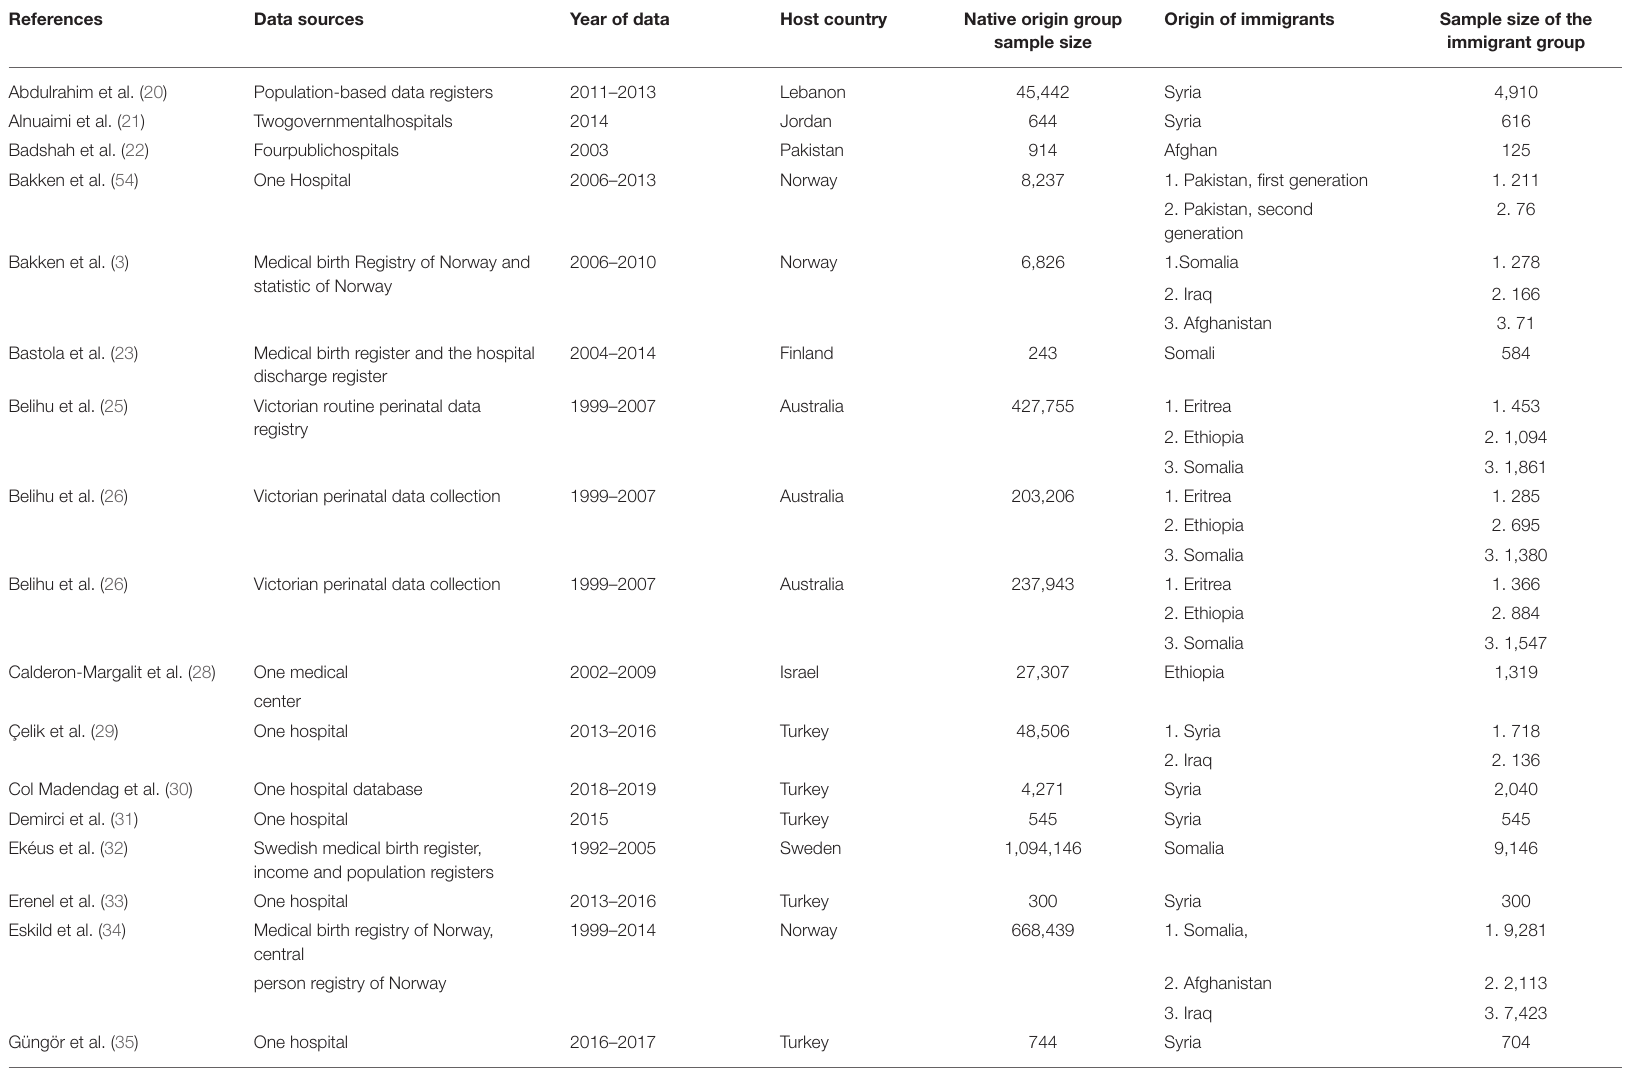
TABLE 1 | A baseline characteristic of the study